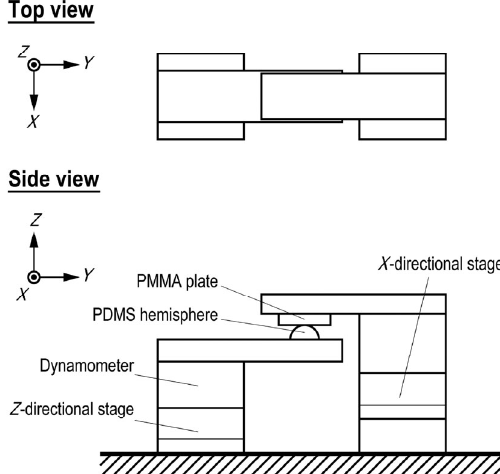
Fig. 10 Schematic of experimental apparatus. The radius of the PDMS hemispheres is 10 mm; specimens with two types of different surface roughnesses are prepared; i.e., for specimens I and II, the Ra values are 2.11 and 4.95 μ m,